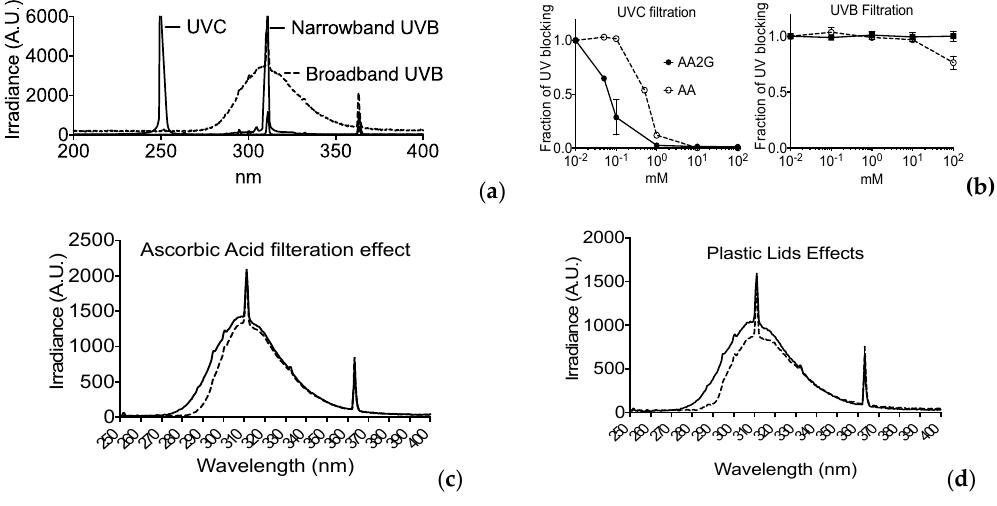
Figure 5. Spectrum of each UV light source and AA and AA2G induced UV filtration analysis: ( a ) Energy spectrum of each UV light source; ( b ) UV reduction analysis with radiometer. Error bars indicate standard error of the mean; ( c ) 1 mM AA induced filtration effects for broadband UVB by spectrum analysis with spectroradiometer. Solid lines indicate spectrum without AA. Dashed lines indicate AA filtered spectrum; ( d ) Plastic lids induced filtration effect for broadband UVB by spectrum analysis with spectroradiometer. A solid line indicates the spectrum without a plastic lid. A dashed line indicates the spectrum with the plastic lid filter.